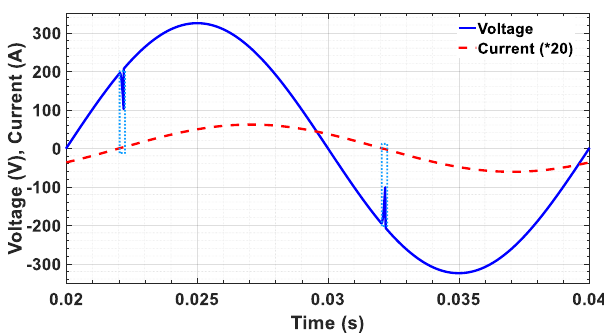
Figure 14. Example of load voltage and current (obtained with a 1 kVA load with power factor PF equal to 0.6) affected by a conduction delay in the AC back to back device.